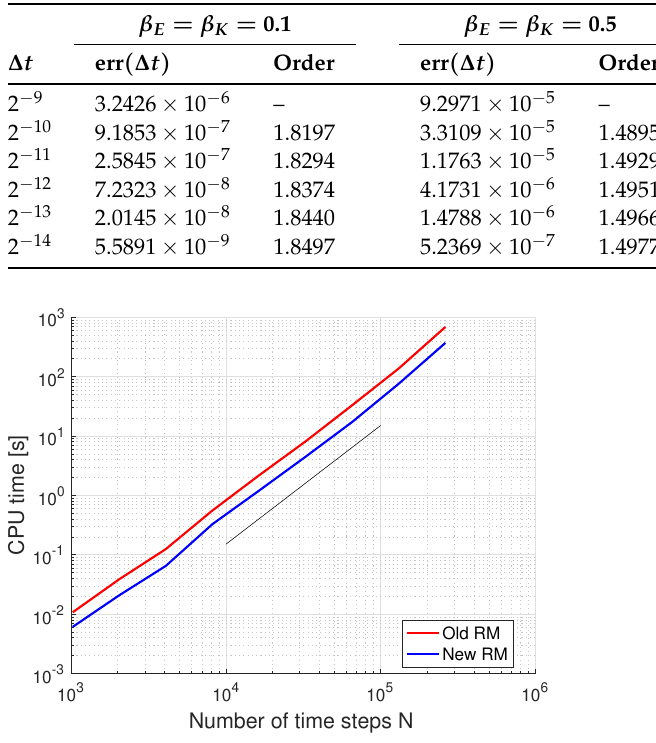
Figure 5. CPU times for the developed fractional return-mapping algorithm and the original one [14] for an SB viscoelastic part. The black line has slope q =